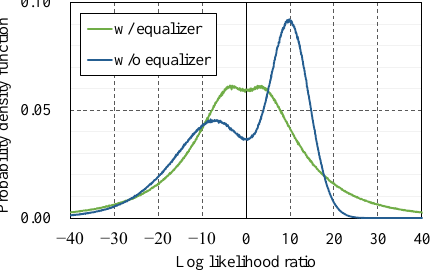
Figure 2. Distribution of LLR L AWGN ( y i , h i ) for OOK scheme with and without channel equalizer. In the simulation, the signal-to-noise ratio (SNR) = 10.0 dB and the intensity variation follows a gamma–gamma distribution with scintillation index of 0.2. For the distribution without equalization, we set h i = 1 for all bits.